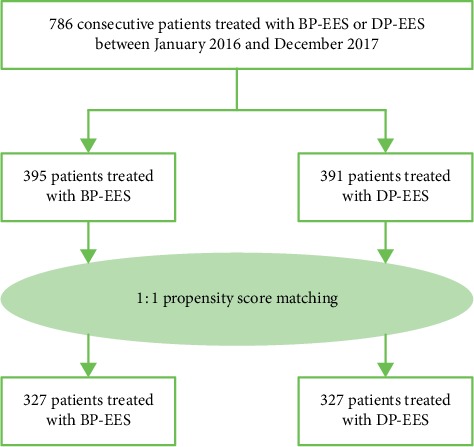
Study flow chart.